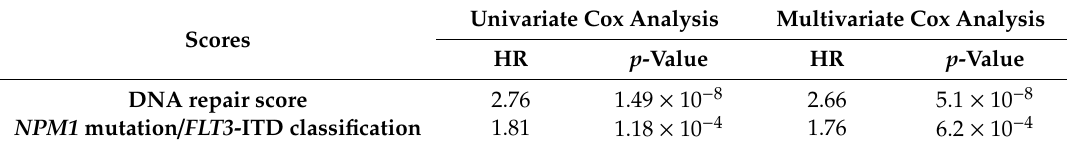
Table 3. Cox analysis of overall survival in CN-AML training cohort ( n = 162) according to DNA repair score, and NPM1 / FLT3 mutational status. Hazard ratio (HR) and p-values are shown for each parameter in univariate and multivariate Cox analysis. ITD: internal tandem duplication.